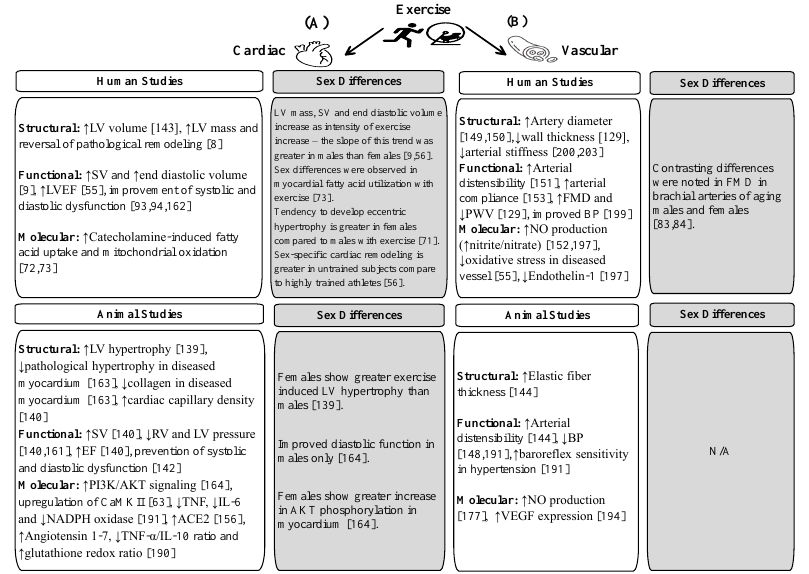
Figure 1. Impacts of exercise and its sex-specific influences on cardiac (A) and vascular (B) re- modeling in humans and animals. ↓ decrease, ↑ increase, left ventricular (LV), stroke volume (SV), left ventricular ejection fraction (LVEF), flow-mediated dilation (FMD), pulse wave velocity (PWV), blood pressure (BP), nitric oxide (NO), right ventricular (RV), ejection fraction (EF), tumor necrosis factor (TNF), interleukin (IL), nicotinamide adenine dinucleotide phosphate (NADPH), angiotensin converting enzyme 2 (ACE2), vascular endothelial growth factor